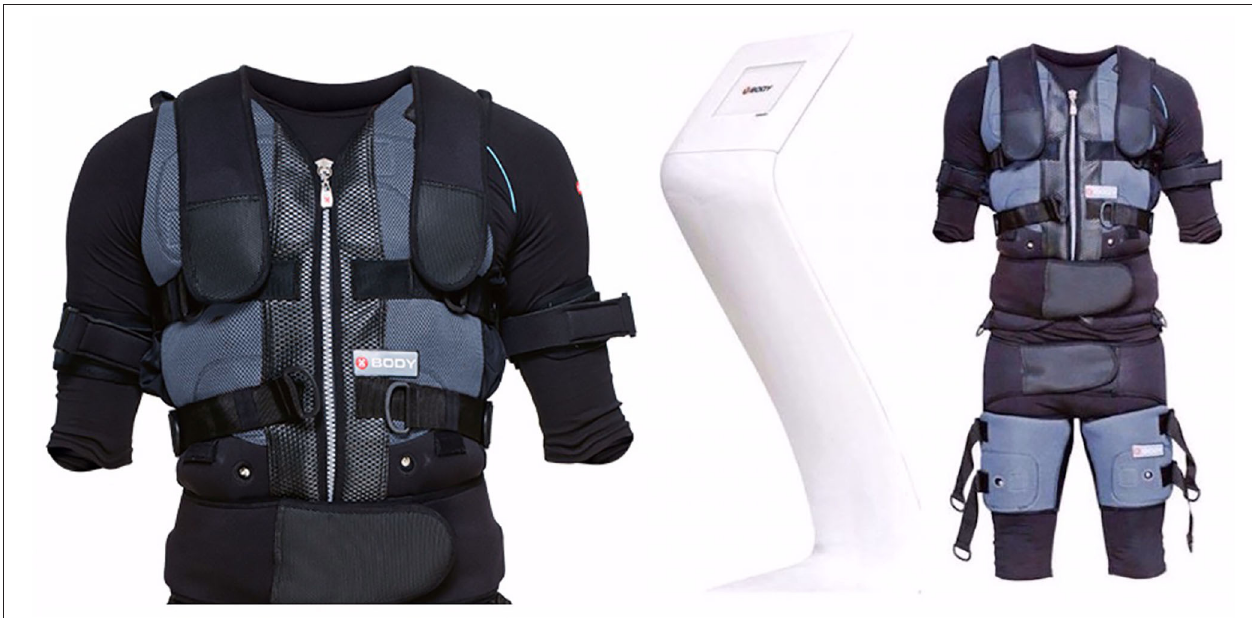
FIGURE 2 | X-body © Whole body electrostimulation equipment.